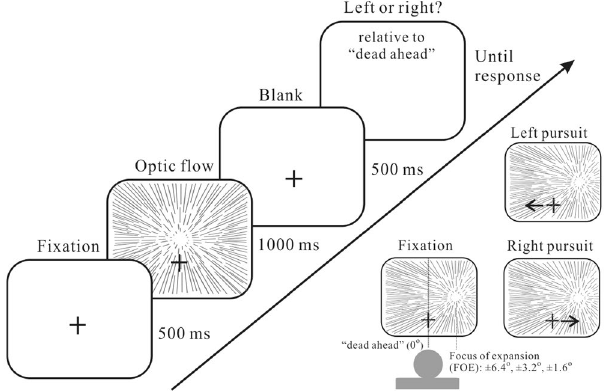
Figure 1. Optic flow perception task and experimental conditions. Participants faced a CRT monitor displaying a cloud of moving dots mimicking the observer’s forward translation on a straight path. The focus of expansion (FOE), which determines the direction of self-motion, could be at one of the six potential positions in a single trial. Participants were asked if perceived direction is to the left- or right- side of the dead ahead. In the fixation condition participants kept their gaze constant whereas in the pursuit conditions they made pursuit eye movements to track the moving